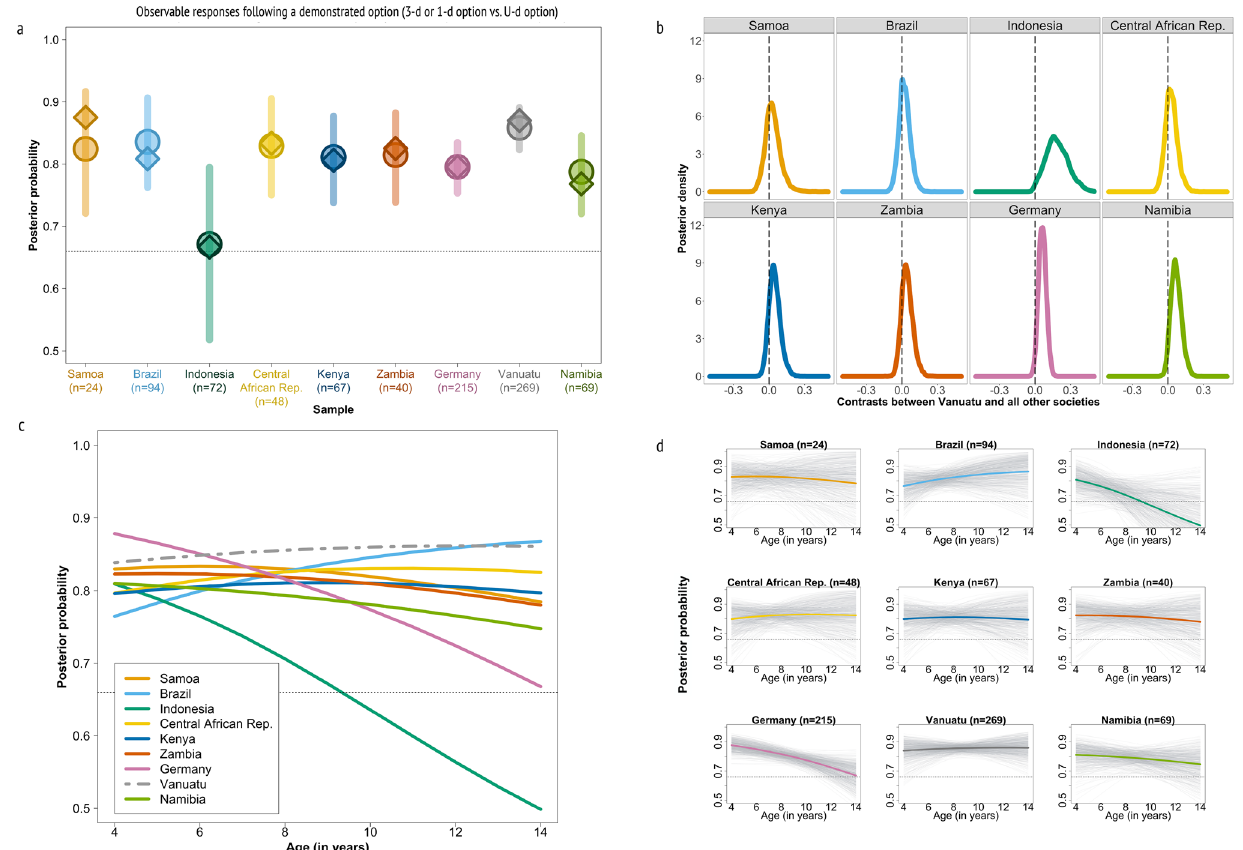
Figure 3. Predictions of the Bayesian multilevel models for observed responses following one of the demonstrated options vs. the undemonstrated option in Vanuatu and eight other societies. Panel ( a ) shows the raw data overlaid on the probability of selecting one of the two demonstrated options vs. the undemonstrated option based on multilevel model estimates. Circles and vertical lines represent the multilevel model estimates and 89% confidence intervals, rhombuses represent the raw proportions in the data. The horizontal dotted line represents the expected proportion if children’s observed responses were random (probability of 0.66). The probability of observed responses following a demonstrated option is consistently greater among ni-Vanuatu children compared to children from the other societies. Panel ( b ) shows posterior density distributions for each society where each is a deviation from the Vanuatu data. This deviation is mostly positive for the probability of observed responses following a demonstrated option. Panel ( c ) shows society-specific age-patterns of children’s observed responses following one of the demonstrated options. ni-Vanuatu children’s observed responses show a constant level of following demonstrated options by age. The horizontal dotted line represents the expected proportion if children’s observed responses were random (probability of 0.66). Panel ( d ) shows society-specific age-trajectories of children’s reliance on a demonstrated option vs. the undemonstrated option. Horizontal dotted lines represent the expected proportion if children’s observed responses were random (probability of 0.66). The light gray lines are 500 lines sampled from the posterior distribution showing the uncertainty of the predicted